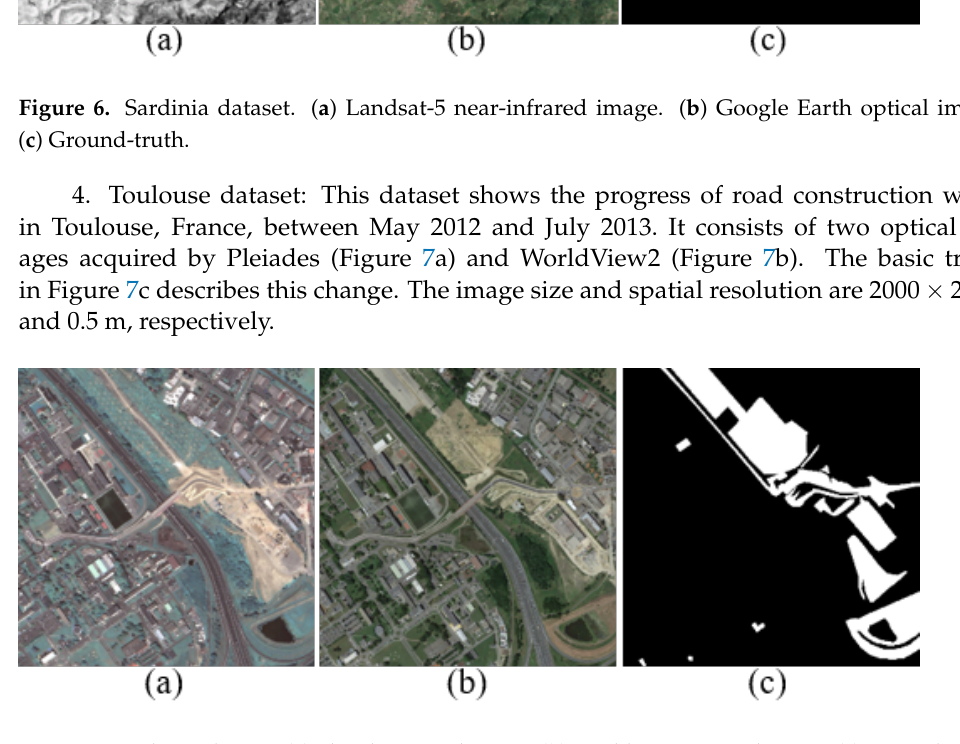
Figure 7. Toulouse dataset. ( a ) Pleiades optical image. ( b ) WorldView2 optical image. ( c )